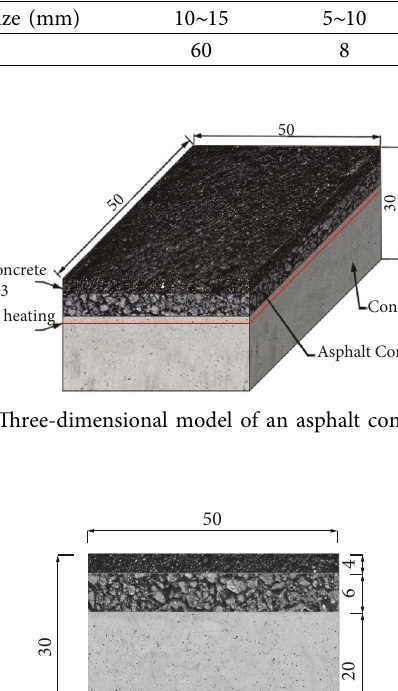
Table 3: AC-13 asphalt concrete mix ratio (kg).